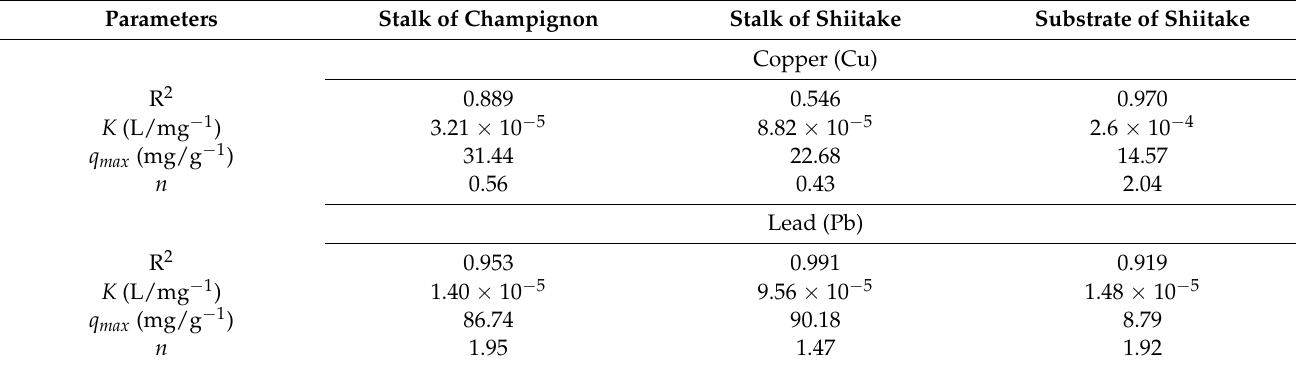
Table 1. A general summary of the isotherm model parameters according to the Sips model and comparing the tree biosorbents evaluated. The K and q max parameters correspond to the equilibrium constant and maximum adsorption capacity, respectively. The heterogeneity is represented by n